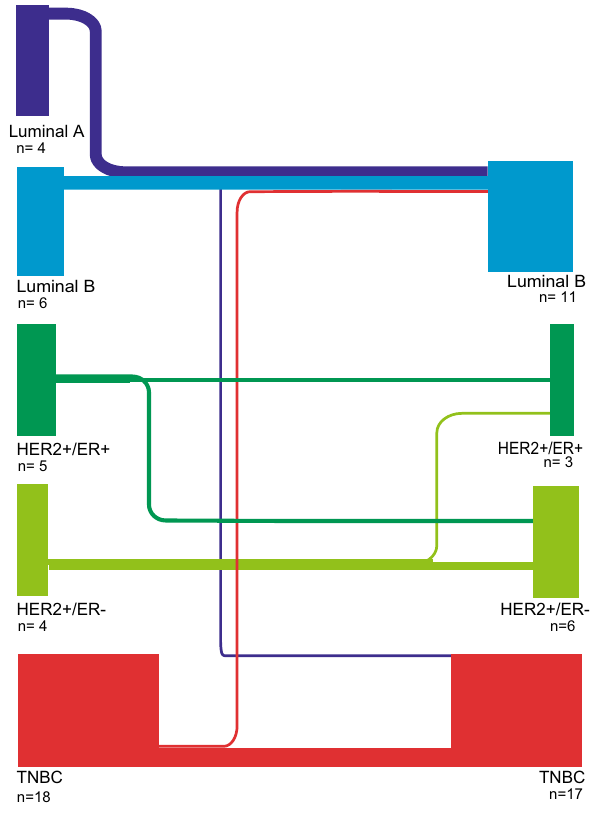
Figure 2. Breast cancer subtype according to expression of steroid receptors, HER2 and Ki67 in primary breast tumors and brain metastases. The thickness of the line represents the number of tumors that changed subgroup in respective